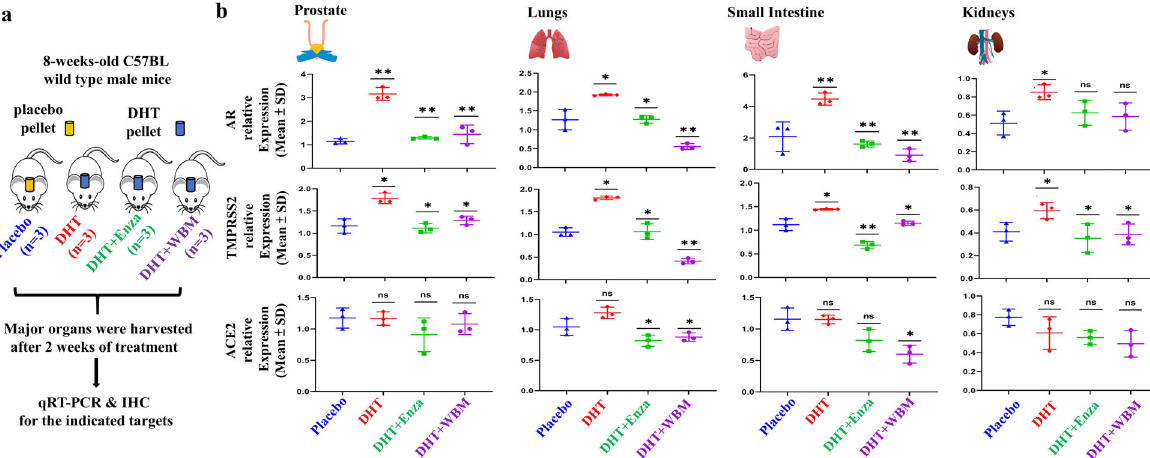
Fig. 2 WBM suppresses DHT-induced AR-TMPRSS2 expression in multiple mouse organs. a Eight-week-old male C57BL/6 mice were subcutaneously grafted pellets (3 mice with placebo pellets versus 12 mice with DHT pellets). The 3 mice with placebo pellets were gavaged daily with 100 μ L PBS for 2 weeks (Placebo group, n = 3). The 12 mice with DHT pellets were randomly divided into 3 groups and treated daily for 2 weeks as follows: 100 μ L PBS (DHT group, n = 3), 300 μ g enzalutamide (DHT + Enza group, n = 3), and 6 mg WBM (DHT + WBM group, n = 3). b The mRNA levels of Ar , Tmprss2 , and Ace2 in the prostate ( n = 3), lungs ( n = 3), small intestine ( n = 3), and kidneys ( n = 3) of each group were quanti fi ed by qRT-PCR. The target mRNA expression was quanti fi ed using the ΔΔ Ct method, as normalized to Gapdh transcript levels. The results were shown as mean ± SD. p Values were determined with one-way ANOVA (* p < 0.05, ** p < 0.01. ns no signi fi cant